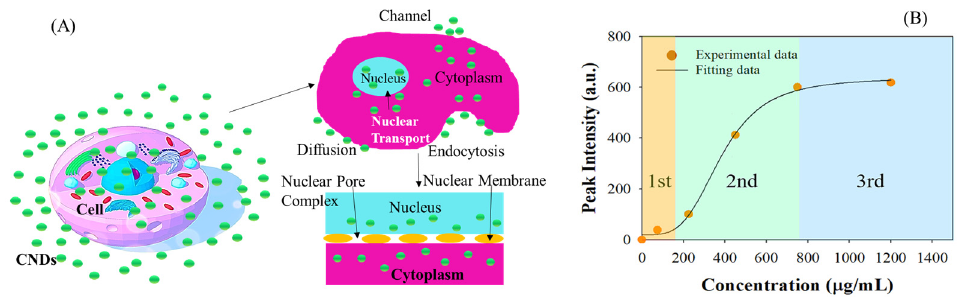
Figure 8. ( A ) Schematic view of the nuclear penetration process of CNDs (the drawing is not to scale). ( B ) The concentration-dependent data analysis of the nuclear penetrability of CNDs and a three-stage model fit.